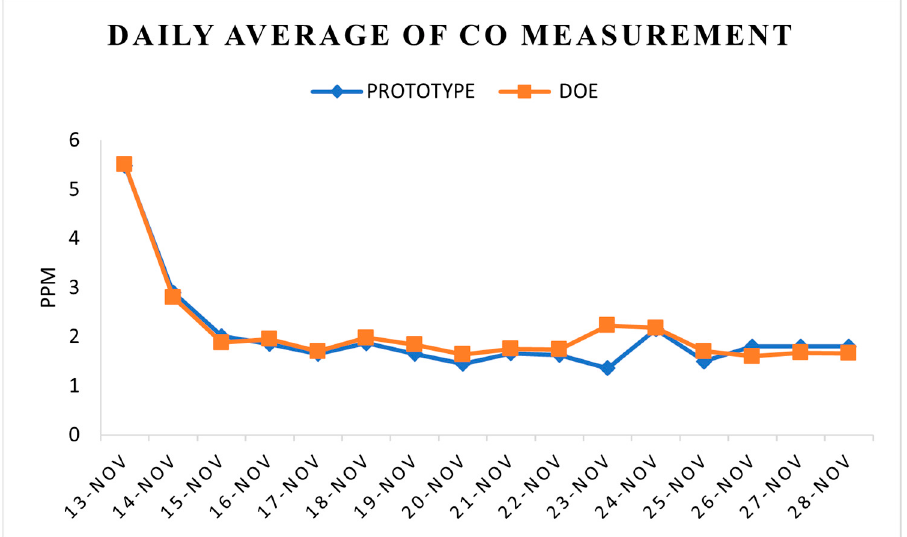
Figure 17. Daily average of CO mass concentration.